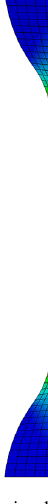
Figure 2: Specimen in tensile testing machine and